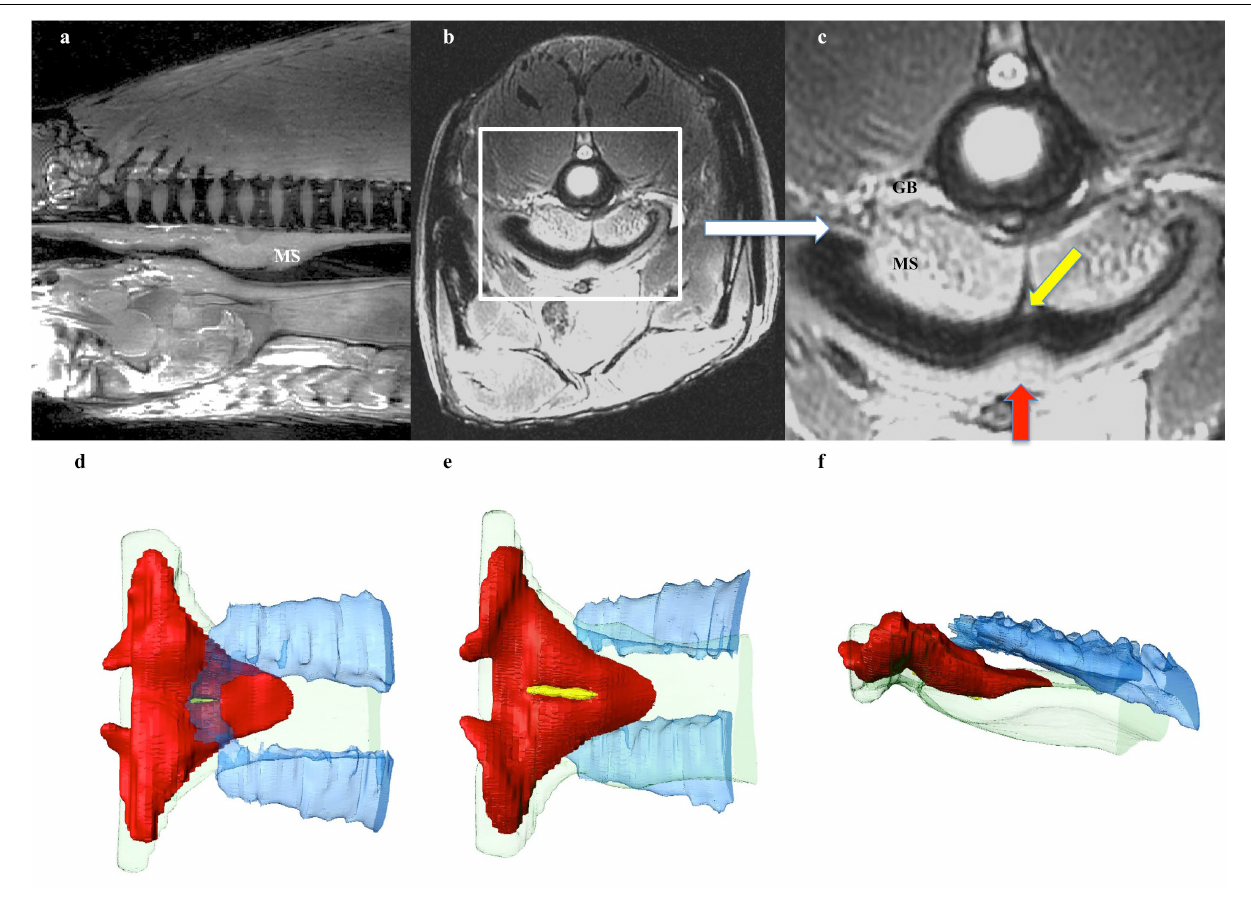
FIGURE 3 | Respiratory system: Esophageal Sphincter. (a) Midline sagittal, and (b,c) axial MRI image at level of upper esophagus through the muscular sphincter (MS), positioned in the dorsal aspect of the esophagus. White box on (b) indicates enlarged section (c) . The sphincter is a triangular, disc-like shaped muscle through which air moves between the esophagus and the rostral aspect of the gas bladder (GB), which is not inflated at this level. A tiny longitudinal strip of tissue seen overlying the opening (yellow arrow in c ), may act as a valve regulating the flow of air, or preventing water/food from entering the GB. In addition a localized thickening of tissue (red arrow) sited on the opposing side of the esophagus, possibly occludes the slit opening when the surfaces of the esophagus are opposed. (d,e) 3D reconstruction of muscular sphincter from CT data demonstrating relationship between the esophagus and the GB. Red: muscular sphincter, blue: rostral end of GB, green: esophagus, yellow: strip of tissue in valve opening. (d) From above sphincter, (e) from below sphincter, (f) lateral